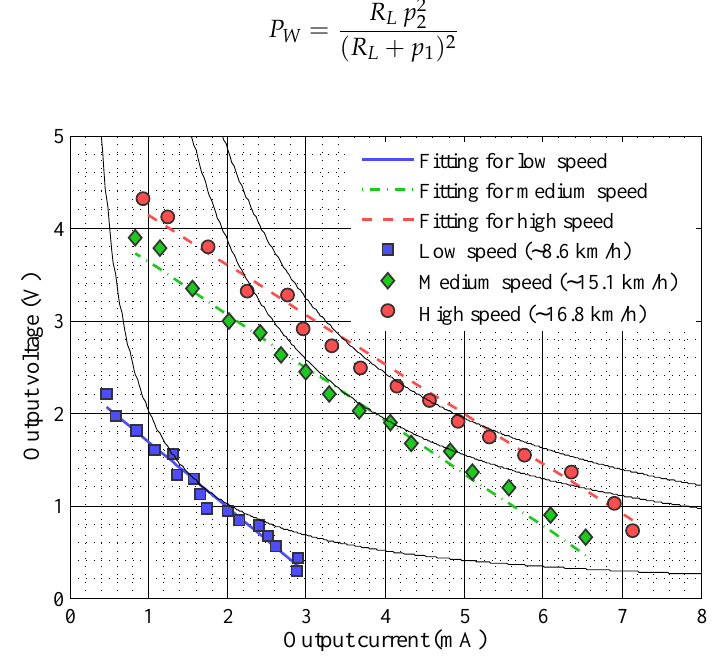
Figure 4. Characterization of the horizontal-axis wind turbines (HAWT) displayed on a V W - I W plot, together with the fitting curves resulting from the analytic model. The solid black curves represent constant power levels: from left to right, the power levels associated to the three curves are 2.02mW, 7.93mW, and 9.95mW (see Table